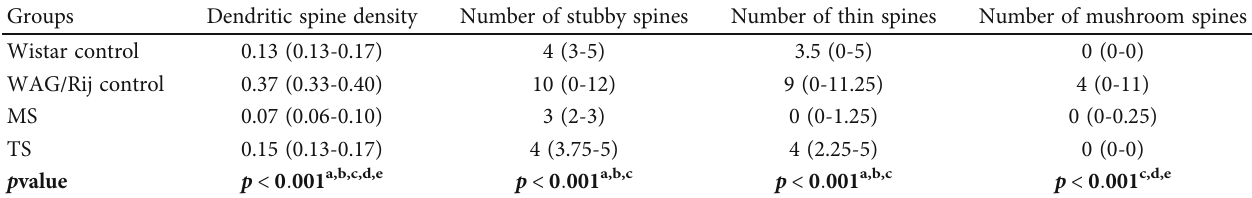
Table 1: Comparison of the groups with respect to the dendritic spine and the number of each spine type.